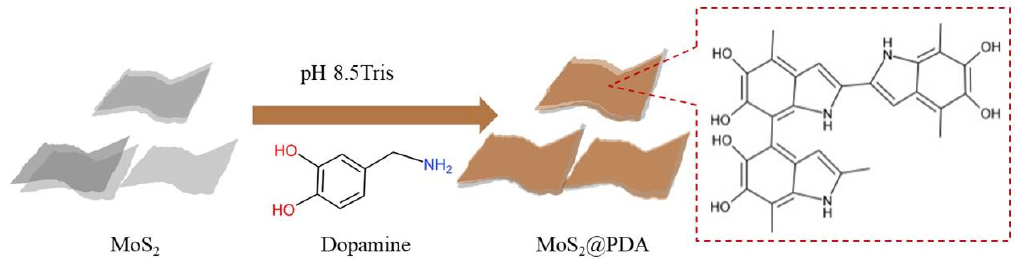
Figure 1. Synthetic scheme of MoS 2 @PDA (polydopamine) nanoparticles.